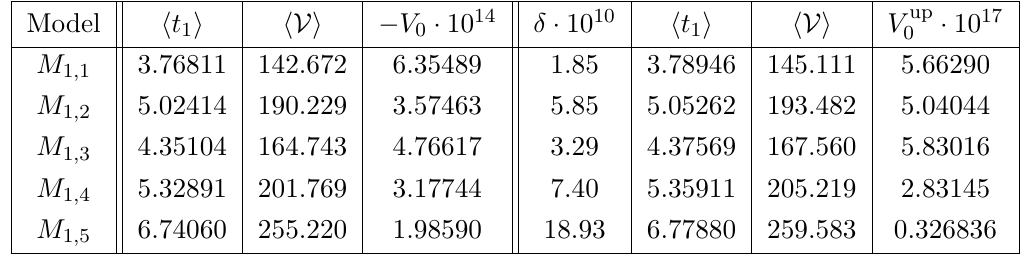
Table 7 . KKLT vacua using the scalar potentials (6.9) and (6.10) before and after the anti-brane uplifting corresponding to p = 6 , and for all the pCICY 3-folds with h 1 , 1 = h 1 , 1 parameters are set as W minimized at h ρ